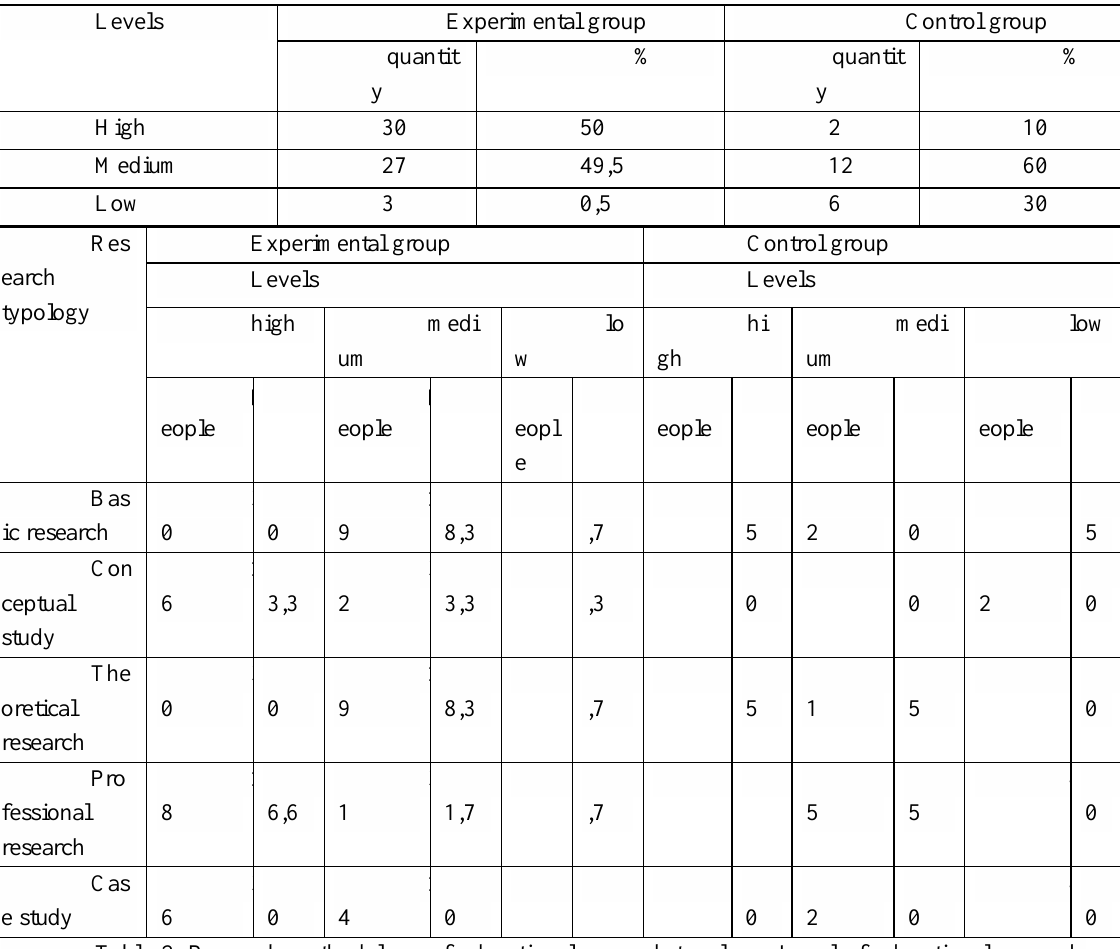
Table 1. Research methodology of professional research orientation. Level of research orientation